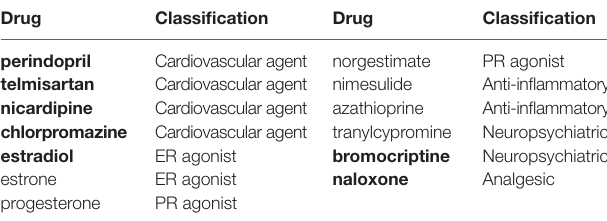
TABLE 3 | Final candidate drugs for